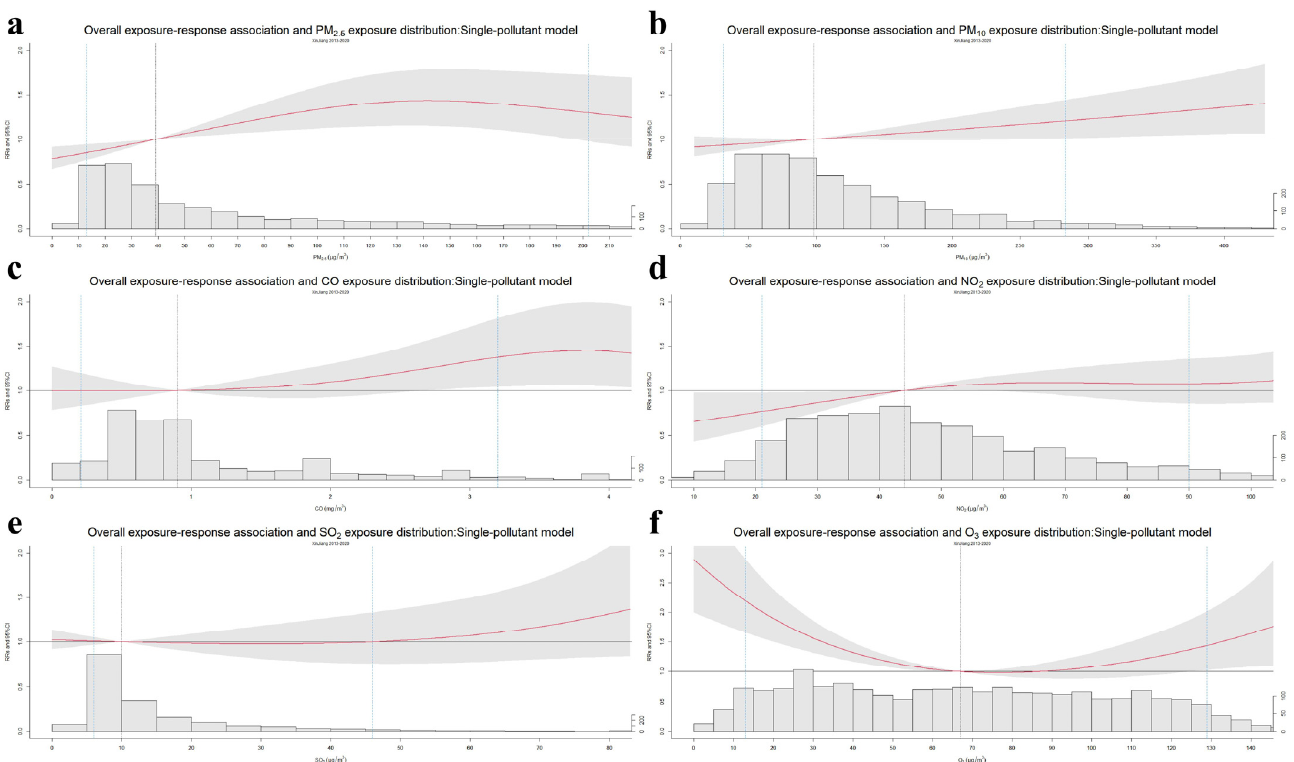
Figure 4. Overall exposure-response association for outpatient visits for DED and air pollutants: PM 2.5 ( a ), PM 10 ( b ), CO ( c ), NO 2 ( d ), SO 2 ( e ), O 3 ( f ) in single-pollutant model.